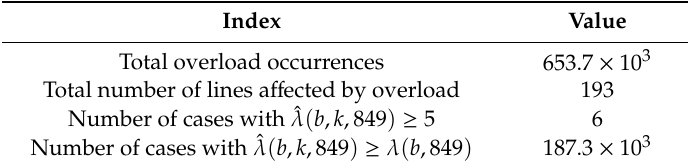
Table 8. Network performances in N − 1 at hour 849 (lines in service–outages).